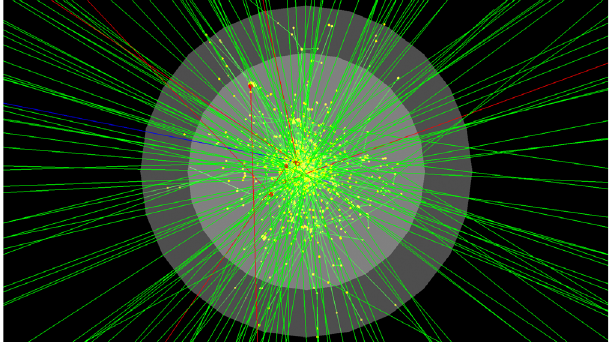
FIG. 13. Driver beam interaction with the collimator. The colors of the tracks stand for electrons (red), positrons (blue), and photons (green) in the γ - and x-ray range.